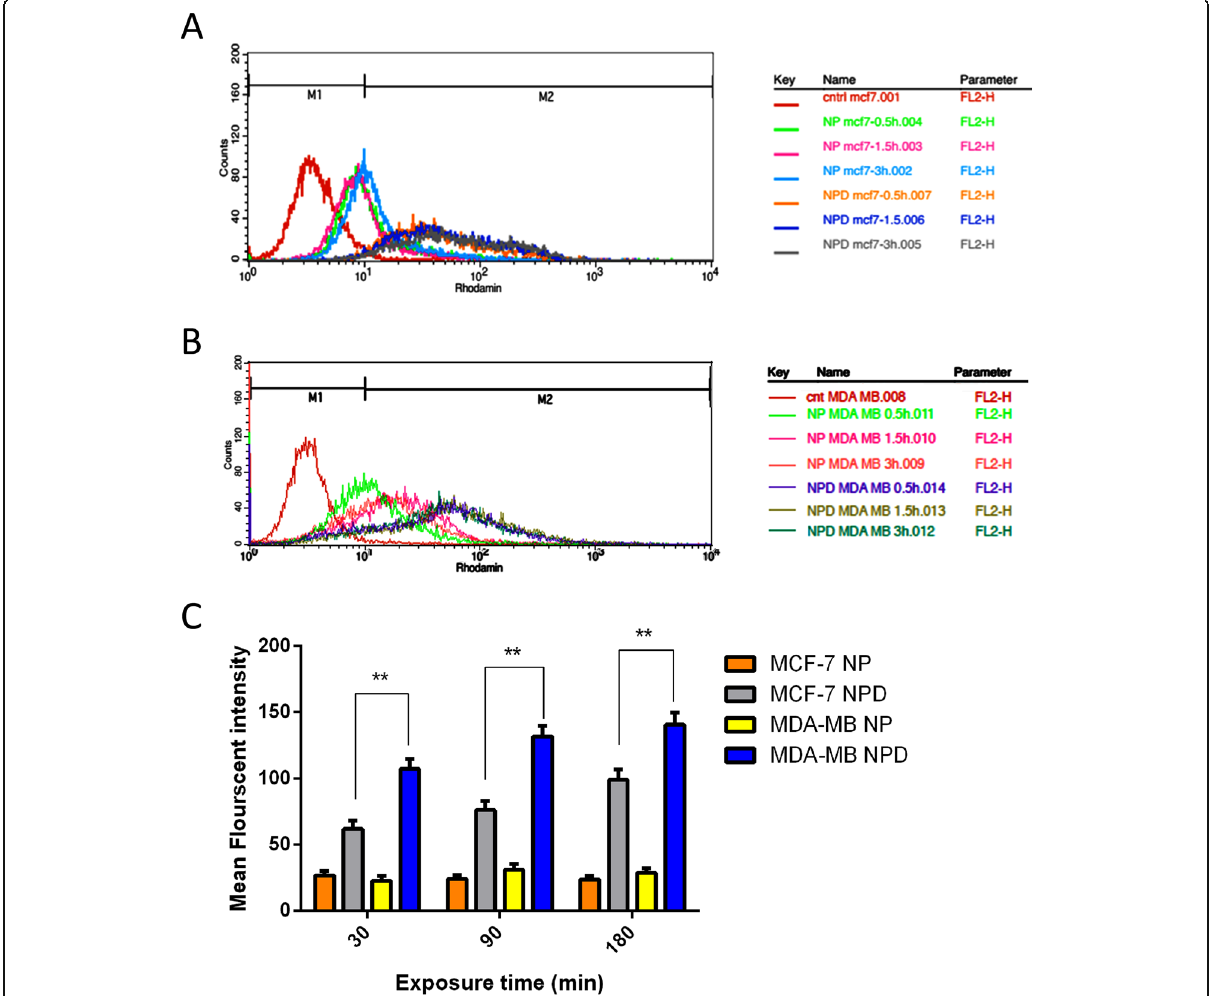
Fig. 4 Quantitative cell uptake assay of rhodamine B-labelled Au@SiO 2 nanoparticles (NP) or rhodamine B-labelled MTX-FA loaded Au@SiO 2 nanoparticles (NPD) in MCF-7 ( a ) and MDA-MB-231( b ) cell lines for exposure durations of 0.5 h, 1.5 h and 3h obtained by flow cytometry. Non- treated cells of both cell lines were employed as negative control. c Comparison of mean fluorescent intensity of rhodamine B-labelled Au@SiO 2 nanoparticles (NP) or rhodamine B-labelled MTX-FA loaded Au@SiO 2 nanoparticles (NPD) for exposure durations of 0.5 h, 1.5 h and 3h